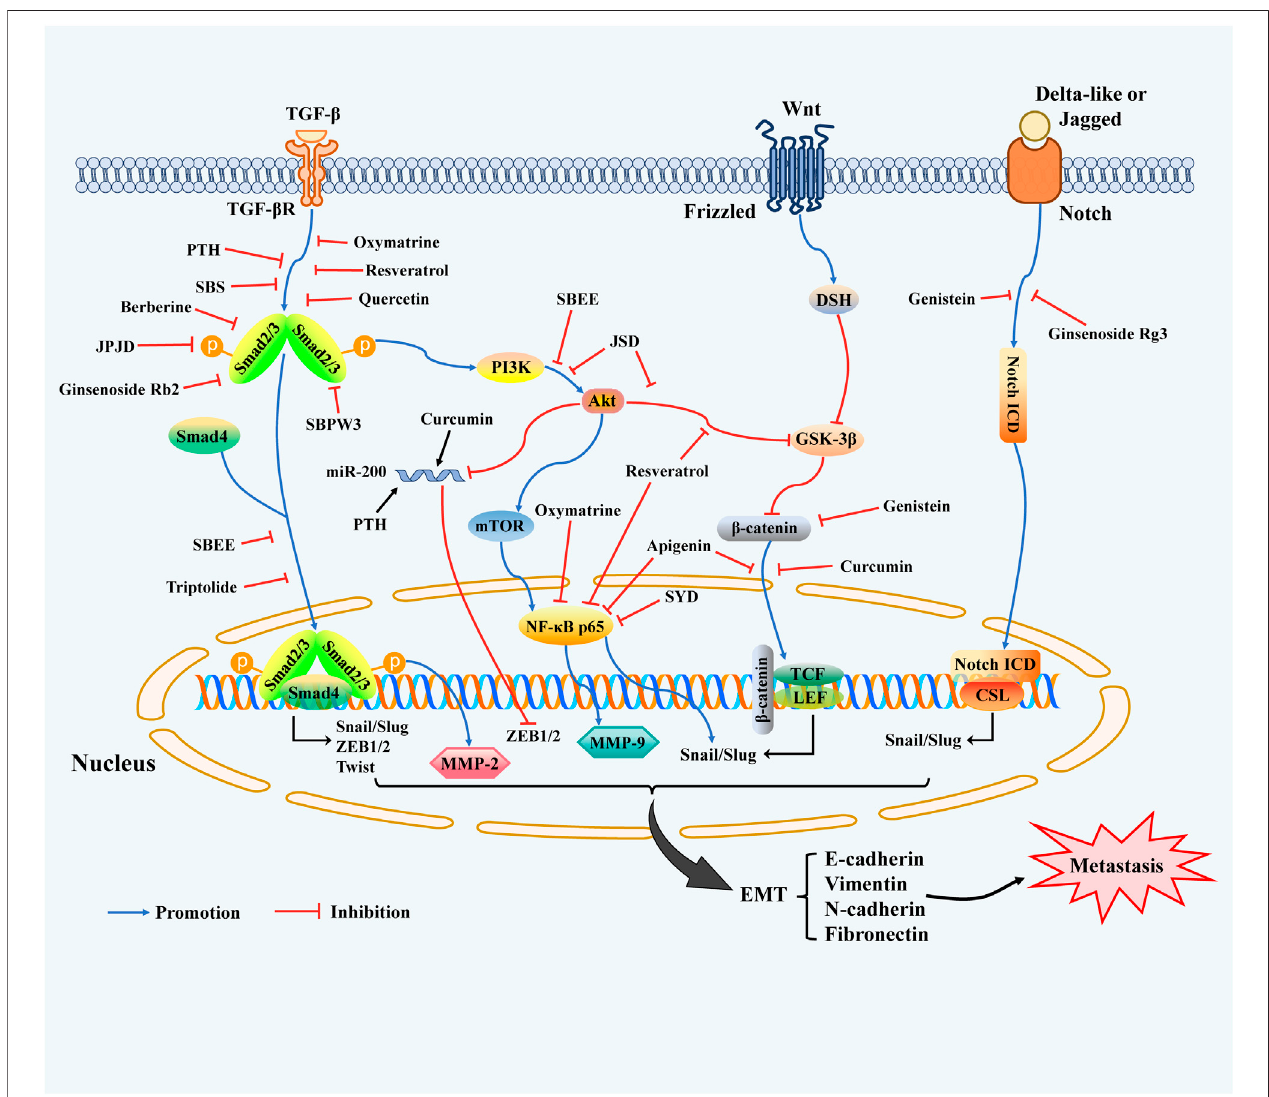
FIGURE 1 | Key molecular targets and related-signaling pathways during the EMT program involved in the inhibition of migratory and invasive characteristics of CRC by TCMs. Notes: Several cell-intrinsic signalings cooperate to induce the expression of EMT-TFs containing Snail, Slug, ZEB1/2, and Twist, the expressions of which are induced by the above-mentioned signaling pathways, including TGF- β /Smads, Notch, Wnt/ β -catenin, PI3K/Akt, and NF- κ B, ultimately leading to transformation to the mesenchymal cell state. In response to TGF- β , Smad2/3 is activated and forms a protein complex with Smad4, and promotes the transcription of EMT-TFs. the expression of which is induced by various signaling pathways. The TGF- β molecular pathway also collaborates with the PI3K/AKT pathway, which in turn triggers the activation of the mTOR complex and NF- κ B. On the other hand, AKT can restrain the function of GSK-3 β , a kinase that inhibits nuclear translocation of ß -catenin and EMT-TFs Snail and Slug in Smad-independent pathways. Furthermore, MMP- 2 expression is positively controlled by Smad2 whilst MMP-9 is modulated via NF- κ B p65/p50 transcription signaling in tumor tissues and cells of CRC. The miR-200 family can down-regulate ZEB1/2 expression, and miR-200 can be blocked by Akt, which is triggered by most EMT-associated signalings. Wnt signaling promotes EMT programme by repressing GSK-3 β through DSH to stabilize ß -catenin, which translocates into the nucleus to engage the transcription factors TCF and LEF and facilitate EMT-related genes expression. Additionally, Notch signaling also participates in EMT progression, behaving as interactions of Delta-like or Jagged ligands with Notch receptors initiate signaling through the proteolytic release of the Notch ICD, and then modulates target gene